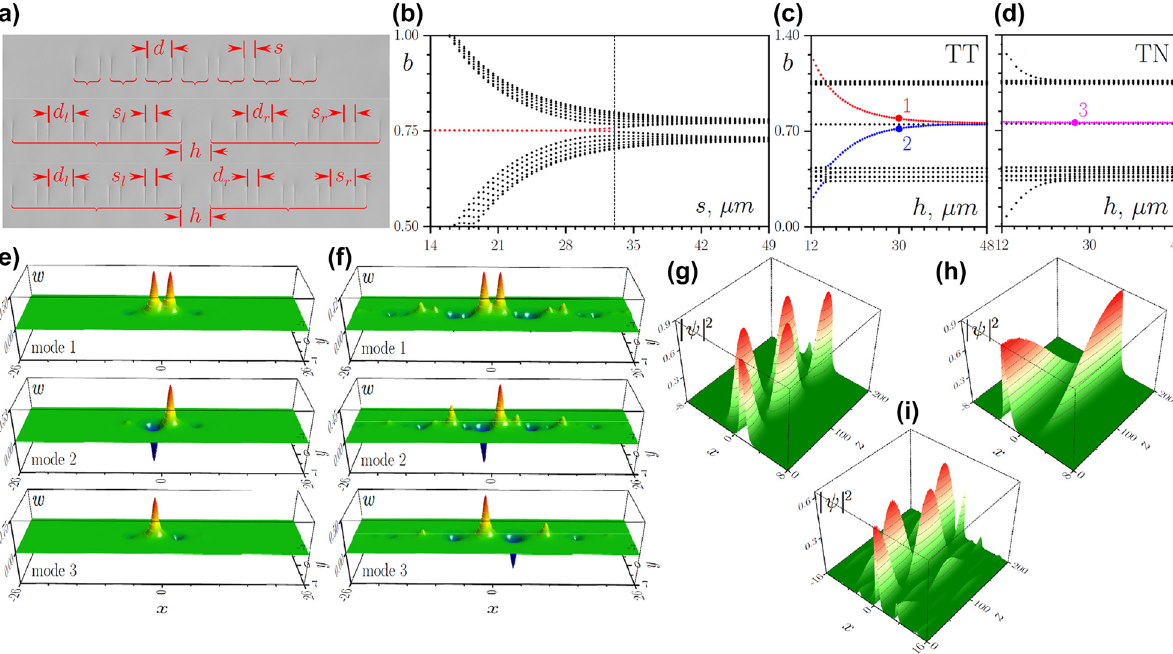
Figure 1: (a) Photograph of the fs-laser written array of dimers in topological regime when inter-cell spacing s = 15 μ m is smaller than intra-cell spacing d = 33 μ m in the entire array (top). Photographs of the interface between two topological arrays with s d l = d r = 33 μ m (middle) and interface between topological and nontopological arrays with s l = d r = 15 μ m and s r = d l = 33 μ m (bottom). (b) Spectrum of modes of the SSH array with 7 dimers versus inter-cell spacing s for fixed d = 33 μ m. Vertical dashed line indicates transition from the nontopological to the topological phase. Eigenvalues of modes supported by the topological-topological = s = 15 μ m, d = d = 33 μ m) (c) and topological-nontopological ( s ( s l r l r between two arrays. (e) Examples of the modes corresponding to dots in (c), (d). (f) Similar modes, but for s = d = 26 μ m, s = d = 33 μ m (TN structure) cases. Switching dynamics in TT structures for the same set of parameters (TT structure) and s l r r l as in (e) at h = 30 μ m (g) and h = 40 μ m (h), and for the parameters of (f) at h = 30 μ m (i). In all cases, p =